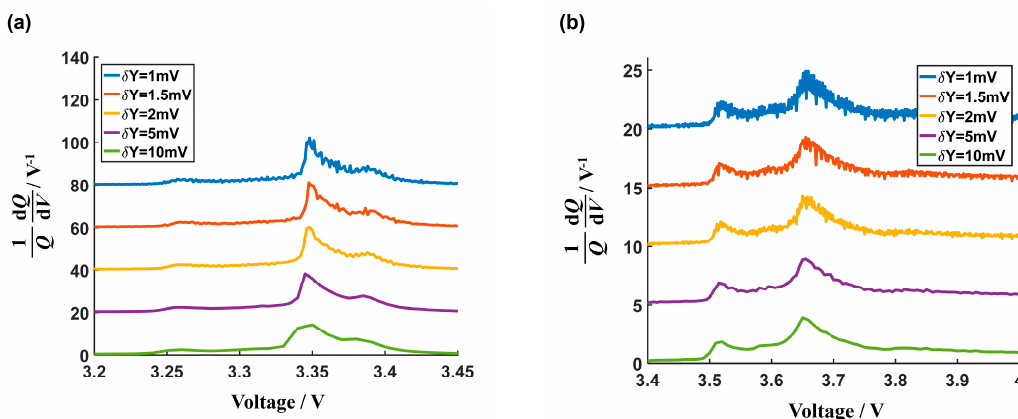
Figure 6. The selection of proper sampling resolution for the approximate linear differentiation in Figure 5a. ( a ) Cell A with LFP cathode. ( b ) Cell B with NCM cathode.